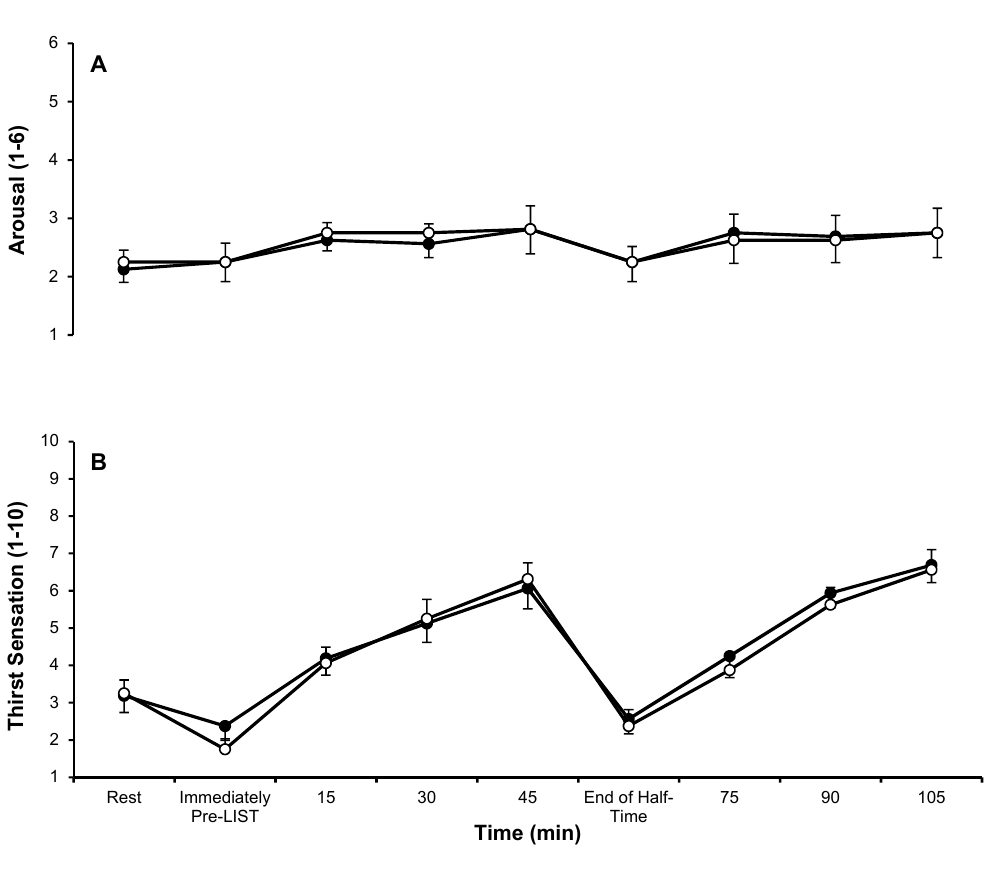
) trials. Data are (cid:35)